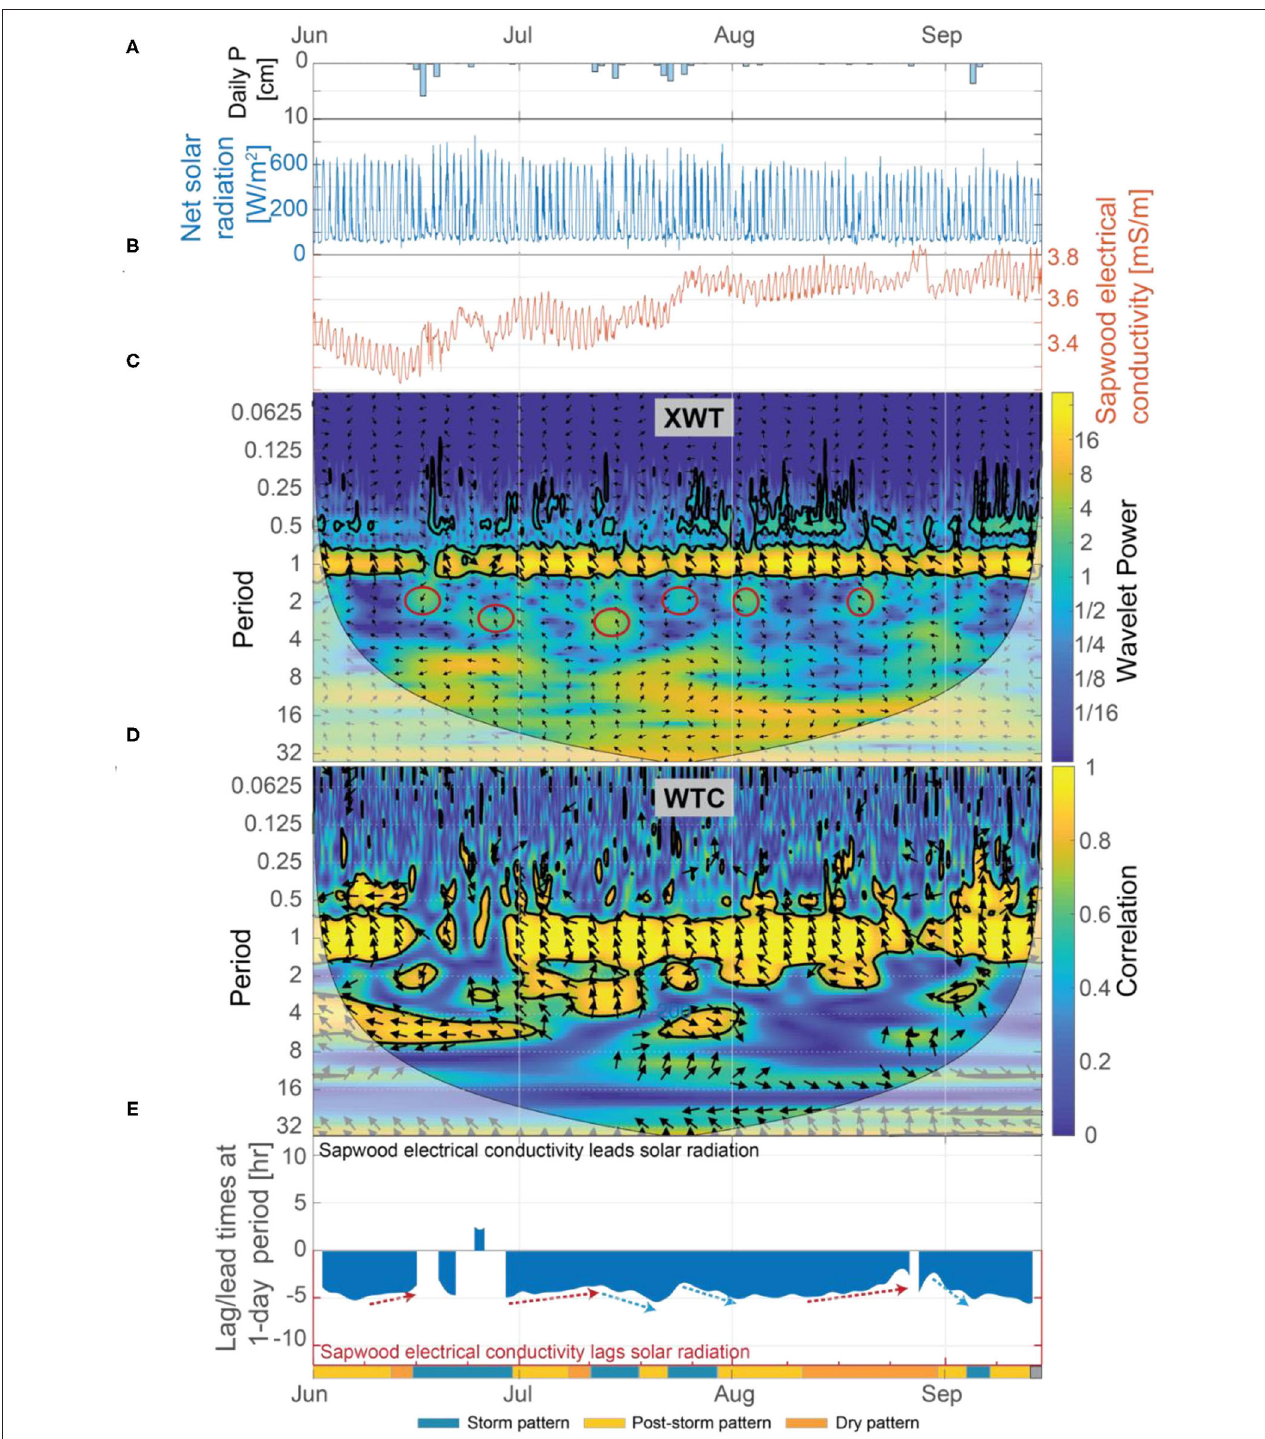
FIGURE 8 | (A) Daily precipitation, (B) net solar radiation and inverted sapwood electrical conductivity, (C) the XWT of solar radiation and inverted sapwood electrical conductivity, (D) the WTC of solar radiation and inverted sapwood electrical conductivity, and (E) the lead/lag time at a 1-day period between solar radiation and inverted sapwood electrical conductivity. Regions in time-frequency space in the XWT that had moderately high wavelet power, periods > 1-day, and where the WTC identified high correlation are outlined with red circles in (C) . The regions outlined in red coincide with the storm events. Red arrows in (E) highlight dry conditions that increased stomatal regulation, and subsequently decreased lag times. Blue arrows in (E) highlight periods of increased moisture, due to precipitation, which decreased stomatal regulation, subsequently increasing lag times.